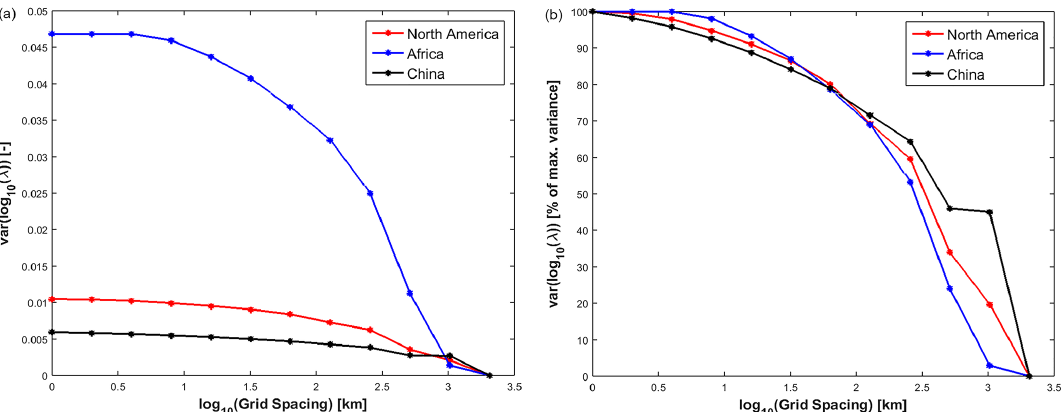
Figure 11. Retention scaling parameter variance var(log 10 ˆ λ i ) for different grid resolutions and regions of interest (North America, Africa and China; see also Fig. 4). (Left) absolute variance and (right) variance normalized as percentage of the maximum variance at 1km original SoilGrids1km